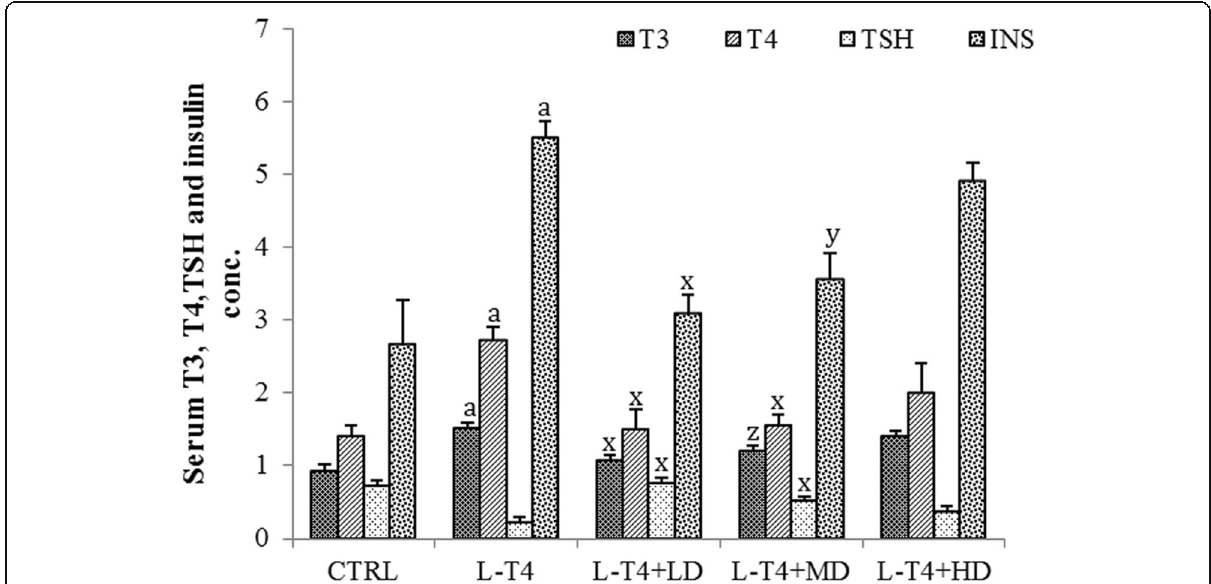
Fig. 1 Effects of ACC on the alterations in serum concentrations of T 3 (ng mL − 1 ), T 4 (ng mL − 1 × 10) and TSH (µIU/ml) in L-thyroxin (L-T 4 )-induced hyperthyroid mice. Each bar represents the mean ± s.e.m., n = 7. Ctrl, Control; T 3 , triidothyronine; T 4 , thyroxine. a P < 0.001 as compared to the respective control values. x P < 0.001, y P < 0.01 and z P < 0.05 as compared to the respective values of L-T 4 treated